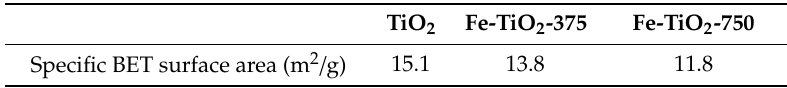
Table 1. The specific Brunauer–Emmett–Teller (BET) surface areas of TiO 2 , Fe-TiO 2 -375, and Fe-TiO 2 -750 particles (the specific BET surface areas of all the synthesized samples are provided in Supporting information 1).